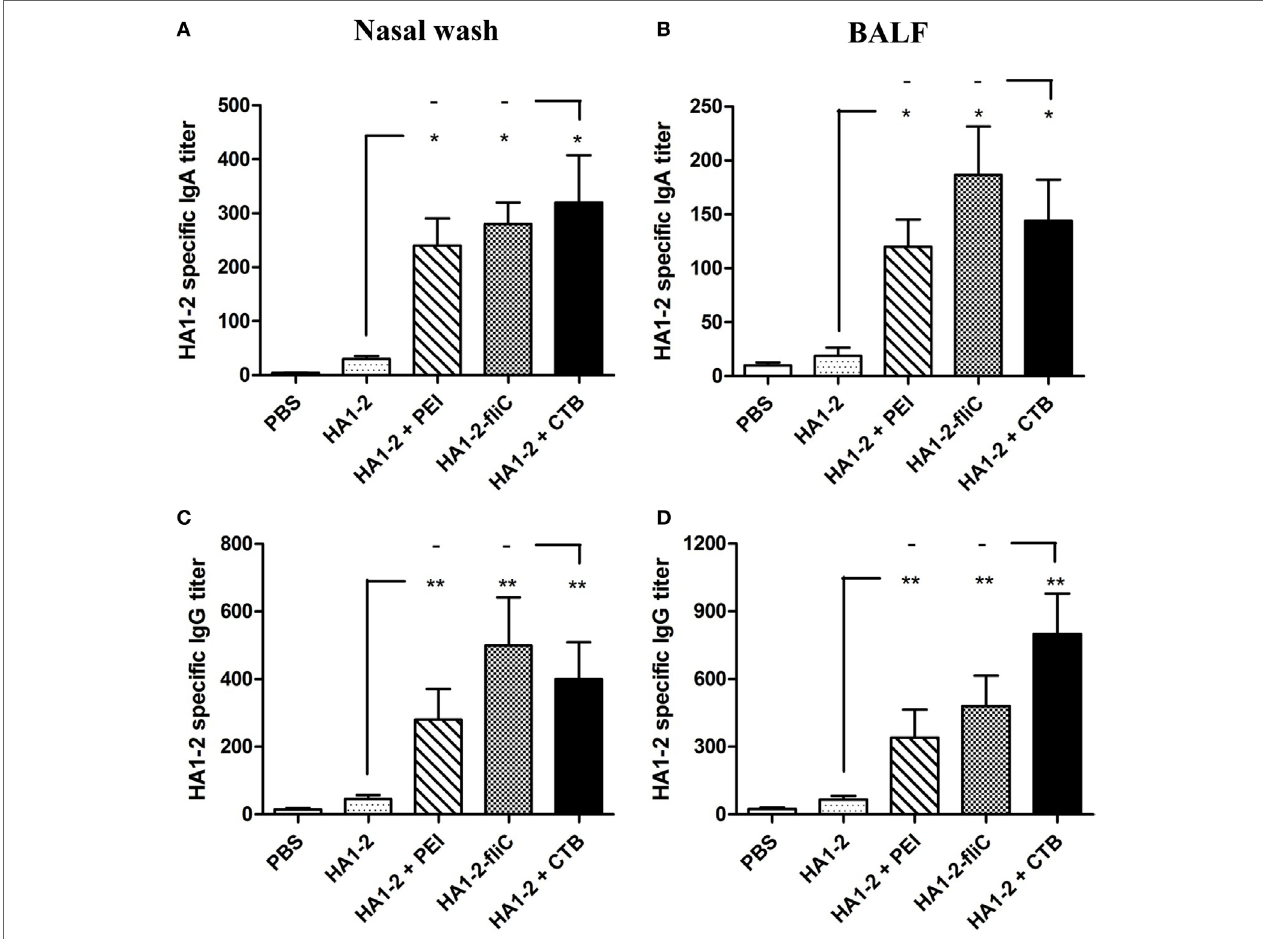
FigUre 4 | antibody responses in nasal wash and bronchial alveolar lavage fluid (BalF) . HA1–2 specific IgG and IgA titers were induced by intranasal immunization with candidate vaccines. (a–D) Nasal wash and BALF samples were collected 2 weeks after the last immunization, and HA1–2-specific IgA and IgG titers in nasal wash (a,c) and BALF (B,D) of immunized mice ( n = 6) were measured by